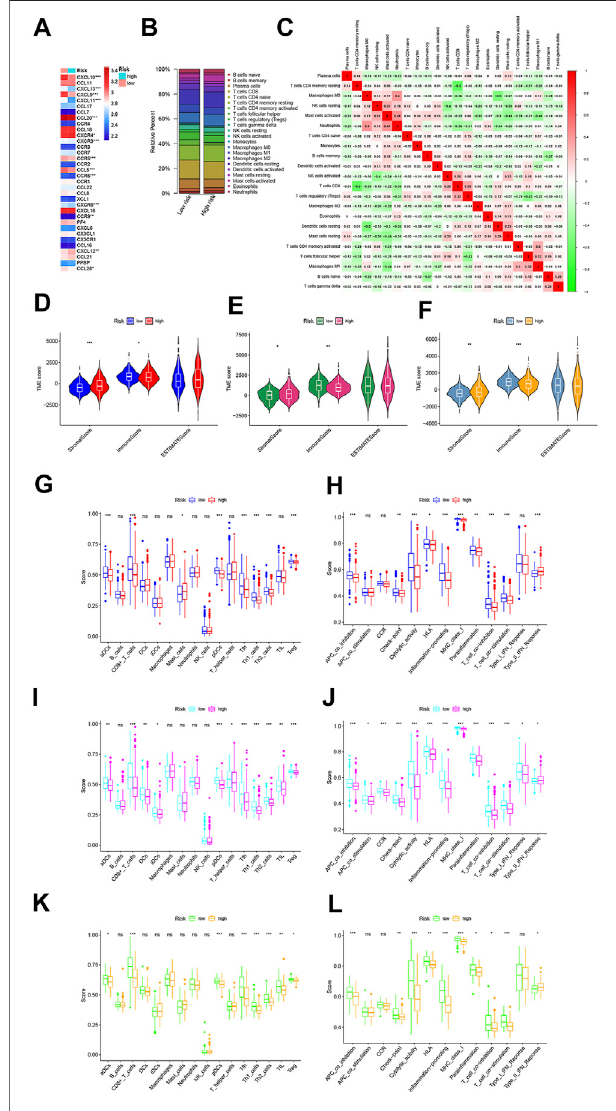
FIGURE 9 | Variations in immune-related genes and the in fi ltration characteristics of TME cells between the high- and low-risk groups. (A) Thermogram shows variations in the mRNA expression of chemokines between the two-risk groups. (B) Bar plot shows the proportion of 22 in fi ltrating immune cells based on the CIBERSORT algorithm between the two-risk groups. (C) Correlation matrix of all 22 in fi ltrating immune cells (red represents positively related and green represents negatively related; p < 0.05 was the cut-off). (D – F) Correlations between the two-risk groups and TME score in GSE39582 (D) , TCGA (E), and GSE17536 (F) cohorts, respectively. (G – L) Comparison of the enrichment scores of 16 types of immune cells and 13 immune-related pathways between low- and high-risk groups in GSE39582 (G, H, respectively), TCGA [ (I, J) , respectively]